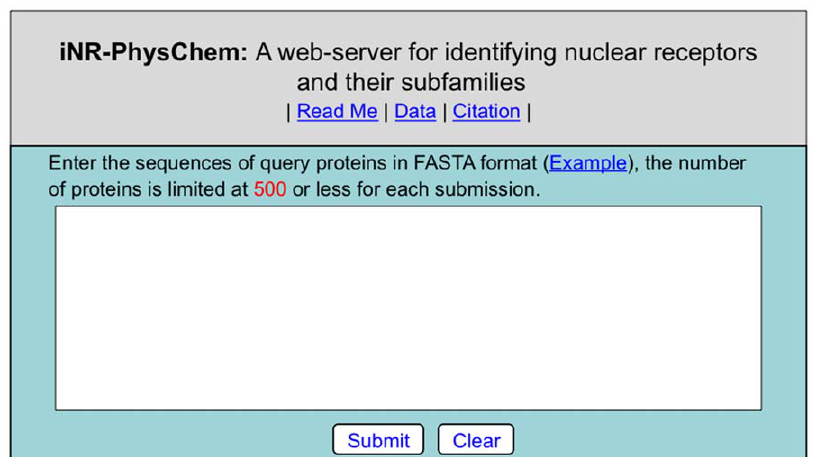
Figure 4. A semi-screenshot to see the top page of iNR-PhysChem. The web-server is at either http://www.jci-bioinfo.cn/iNR-PhysChem or http://icpr.jci.edu.cn/bioinfo/iNR-PhysChem.